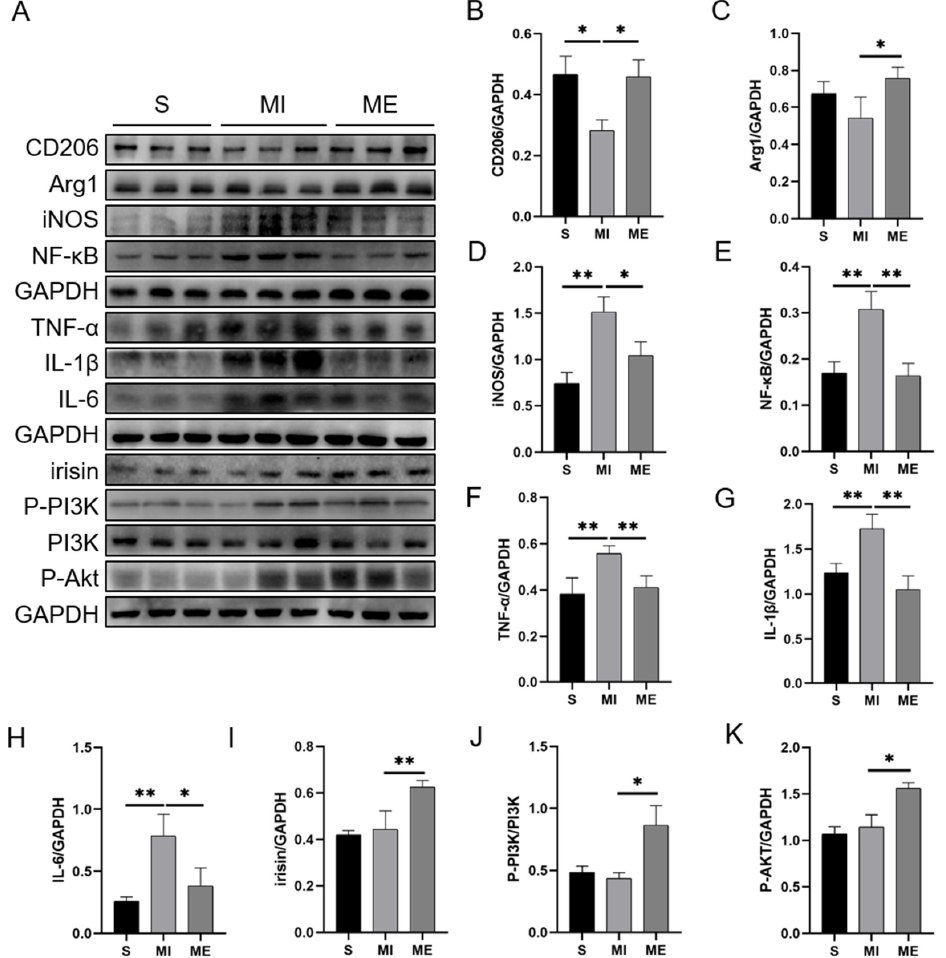
Figure 2. Effects of AE on the macrophage polarization, inflammatory response, and activation of irisin/PI3K/Akt signaling pathway in the livers of the MI mice. ( A ), Western blotting results; ( B , C ), analysis of the expressions of CD206 and Arg1. ( D – H ): analysis of the expressions of inflammatory factors. ( I – K ), analysis of the activation of the irisin–PI3K/Akt signaling pathway. Data are expressed as mean ± SEM, n = 3. * p < 0.05, ** p < 0.01 by one-way ANOVA. S: sham group; MI: myocardial infarction group; ME: MI with AE group.